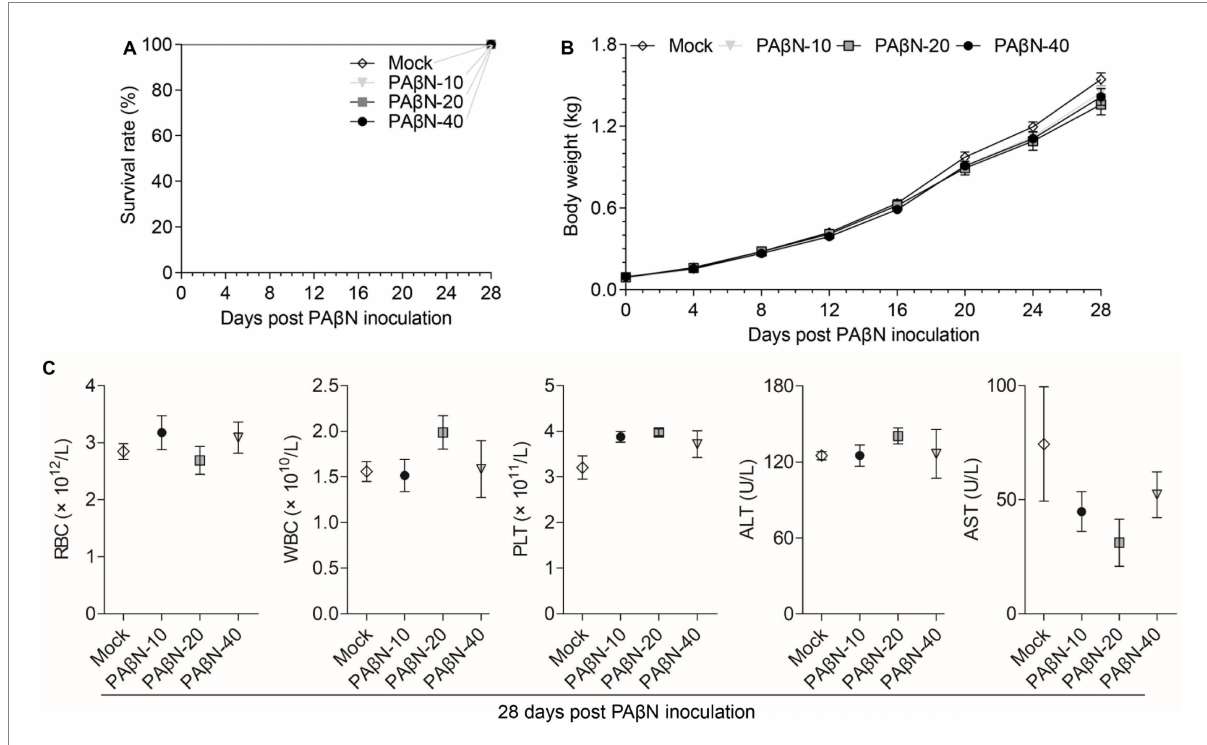
FIGURE 3 Safety evaluation of PA β N in vivo . (A) Survival curves of ducks injected with PA β N. (B) Body weights of ducks injected with PA β N. (C) Results of blood cells and blood biochemical tests (mean ± SD, n = 5). RBC, red blood cell; WBC, white blood cell; PLT, platelet; ALT, alanine aminotransferase; and AST, aspartate